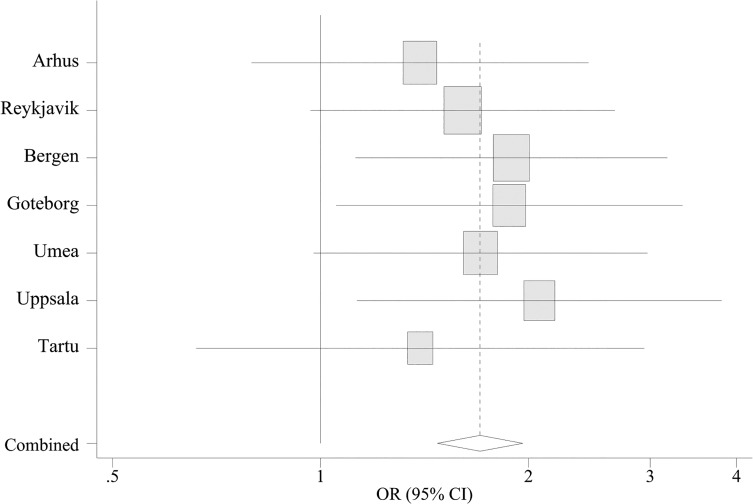
Adjusted odd ratios for the association of occupational cleaning with asthma symptoms (≥3 symptoms) in each study centre, as estimated from meta-analysis.For each centre the square gives the OR and the horizontal lines indicate 95% CI; the area of the square is proportional to the size of the study sample in each centre. Adjustment within each centre made for sex, smoking habits, age, education level, parent´s education level, BMI and participating centre. For combined odds ratios, the diamond indicates 95% CI from a model with centre as random effect. p-value for heterogeneity = 0.8.